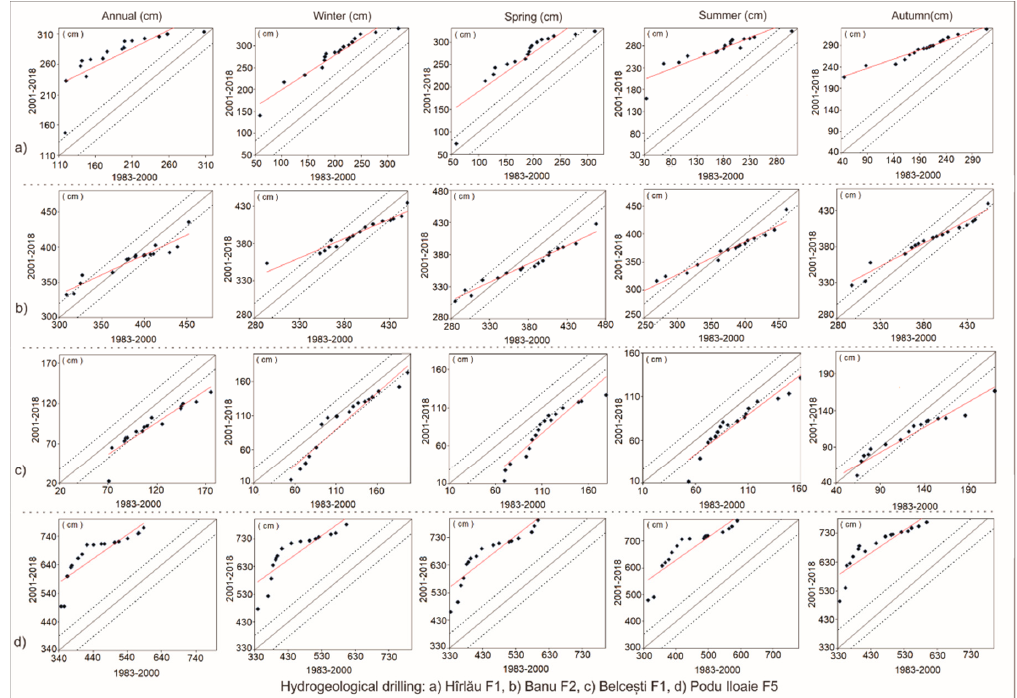
Figure 3. Trend analysis for season groundwater level based on ITA ( a ) Harlau F1, ( b ) Banu F2, ( c ) Belce ș ti F1, ( d ) Podu Iloaiei F5.